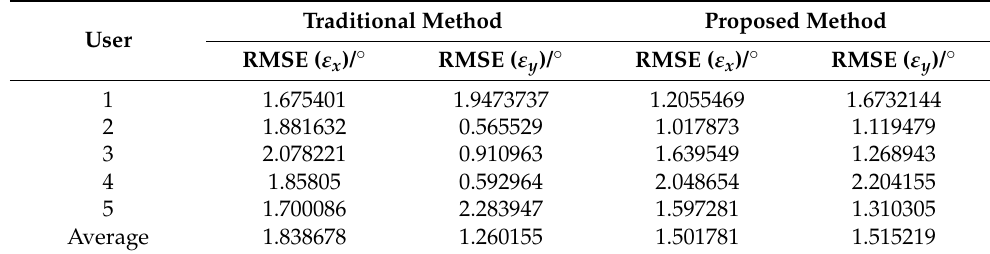
Table 8. Comparison of 3D gaze estimation